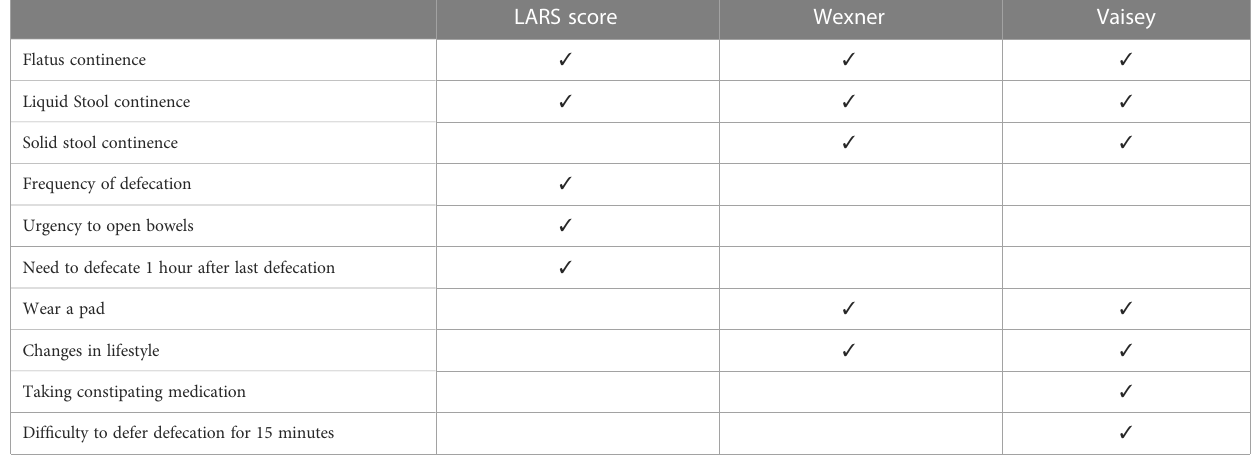
TABLE 1 Comparison of items of LARS score, Wexner and